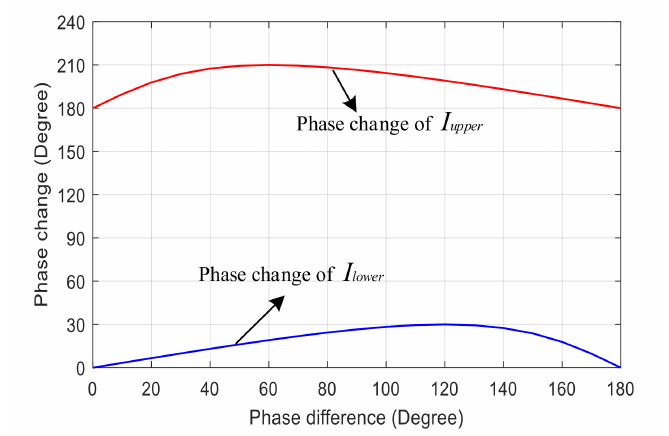
Figure 2. Phase change of I upper and I lower